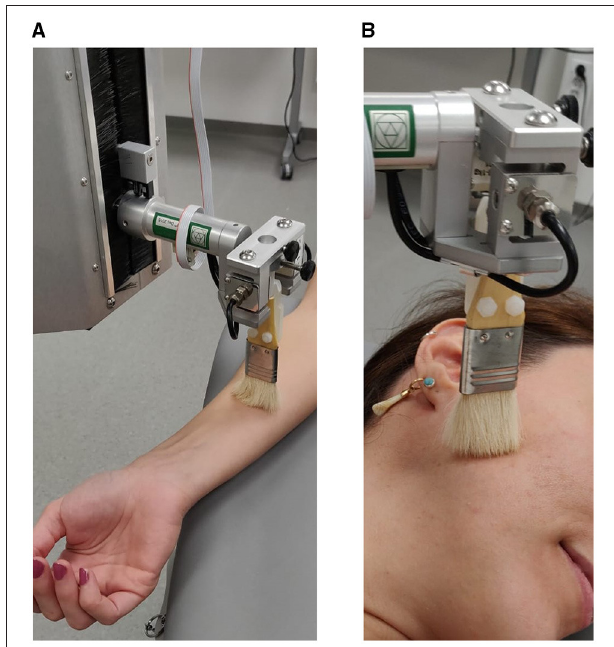
FIGURE 1 | Overview of the experimental setup. Tactile stimulation was delivered by the RTS while the participant was lying flat with right forearm extended (A) and head turned to expose right side (B)